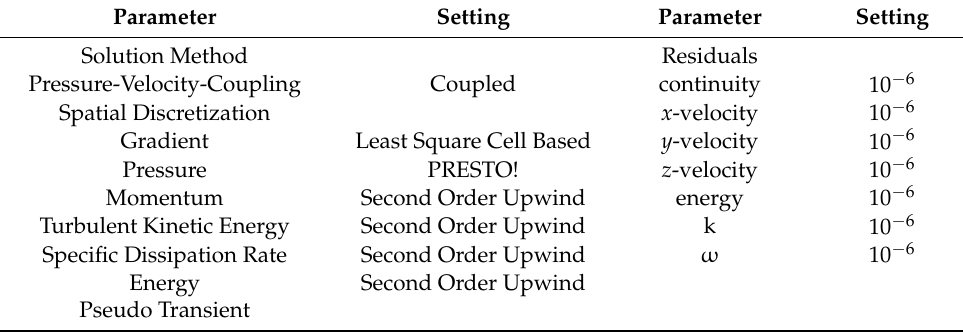
Table 2. CFD simulation